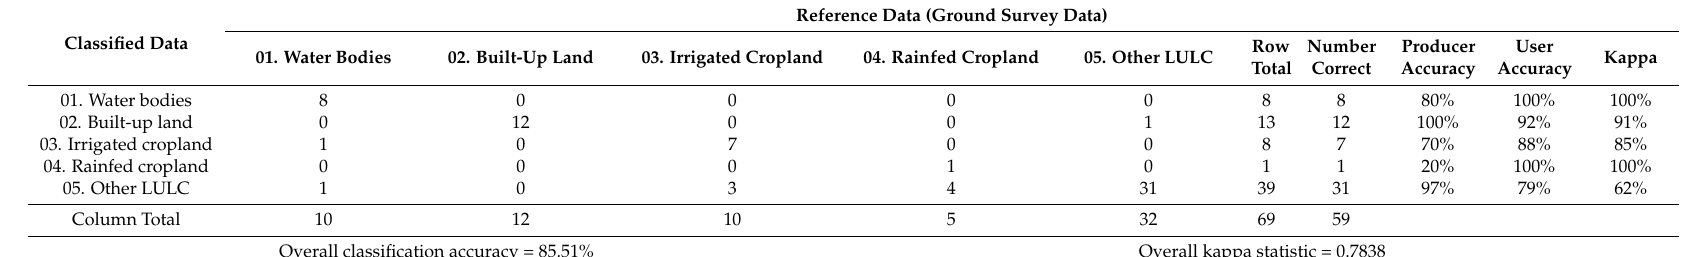
Table 5. Validation of land-use/land-cover (LULC) classes in 2016, based on ground survey